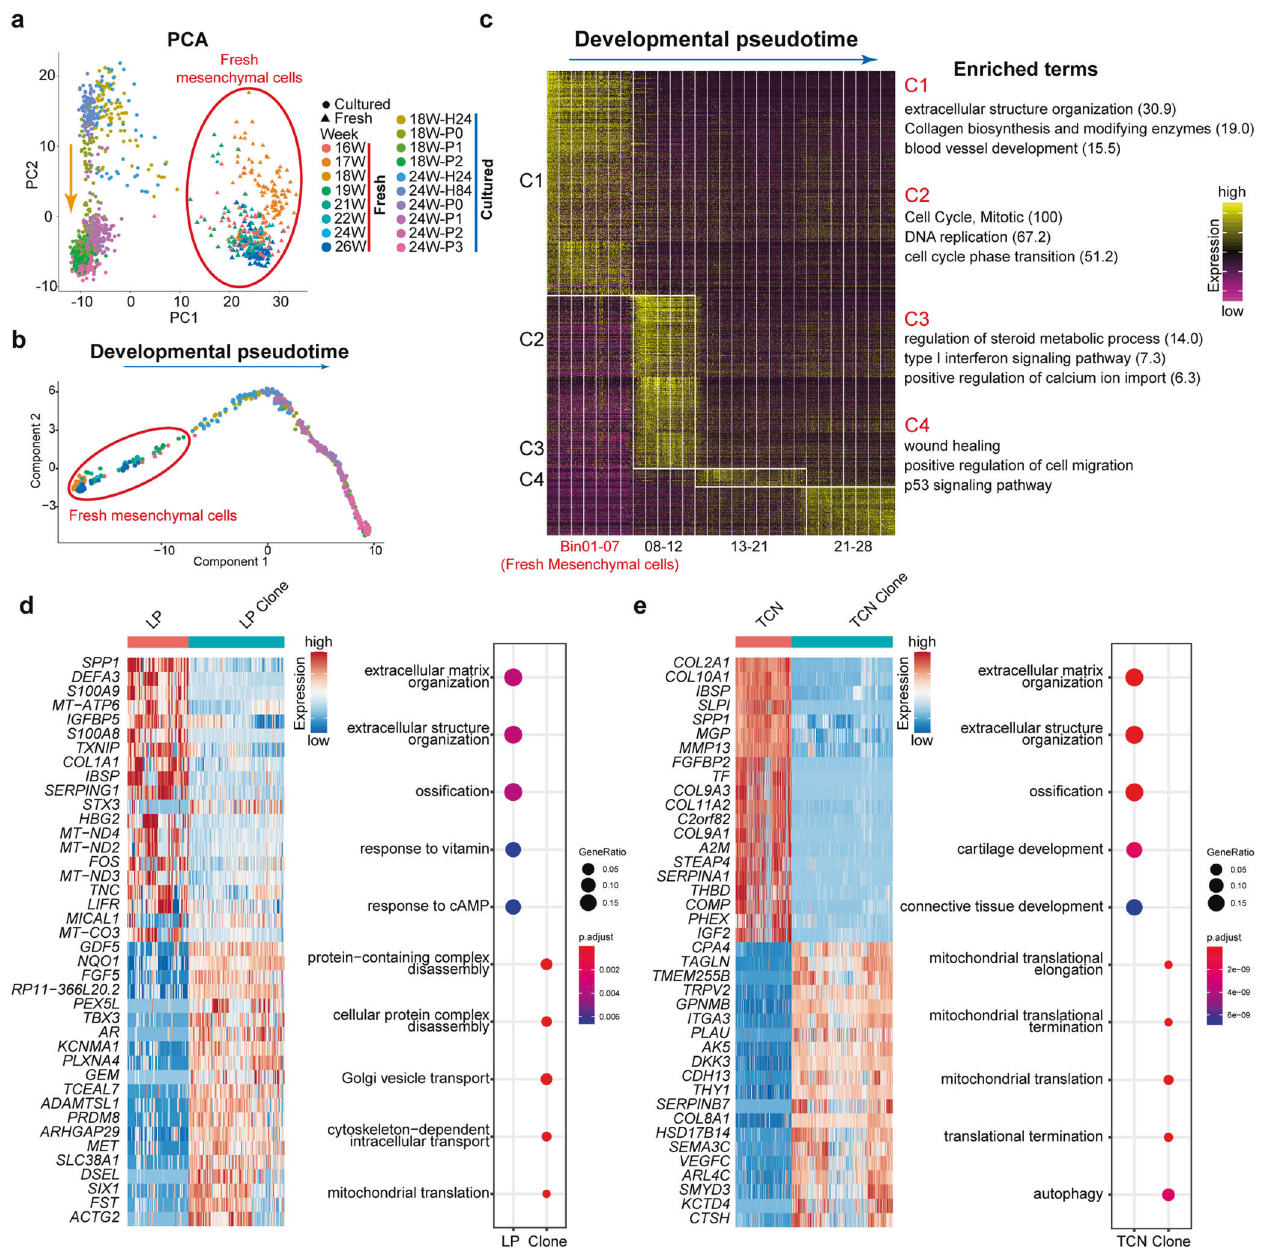
Fig. 6 Comparison between primary and cultured BM mesenchymal cells. a PCA plot showing relationship between primary and cultured BM mesenchymal cells. b Developmental pseudotime of primary and cultured BM mesenchymal cells. c Cells were split into 28 bins along the developmental pseudotime. Each bin contained 50 cells and the DEGs of each bin were shown by the heatmap. All bins were classi fi ed into four major clusters according to their expression patterns. And the enriched terms using all the DEGs in each cluster were listed on the right. The number in the bracket indicates – log10 ( P -value). d DEGs (left) and GO terms (right) showed that the fresh LP cells and LP clones exhibited high heterogeneity. e DEGs (left) and GO terms (right) showed that the fresh TCN cells and TCN clones exhibited great high great difference before and after culture. Both of which further expansion that could preserve the original disposition and suggested that the characteristics of MSC in vitro are not fully progenitor function of MSCs would be a great help for MSC- indicative of in vivo function. based bone regeneration. We also examined the CFU-F activity of Despite the bene fi cial effects of MSC therapy both in pre- human fetal BMNCs (Fig. 5). Stromal cells with CFU-F activity and clinical and clinical trials, more and more studies have produced multi-lineage differentiation ability in vitro were generally mixed results regarding their therapeutic ef fi ciency. The great identi fi ed as MSCs. However, many bone marrow stromal cells changes between freshly isolated MSCs and cultured cells may have the ability of multi-lineage differentiation potential and CFU- suggest a possible explanation for the discrepancy between F activity in vitro, but failed to form new bone when transplanted expected and actual results of MSC therapy. In the present in vivo. On the other hand, the expression pattern of many surface study, gene-expression pro fi les indicated an apparent gap markers, which are generally used for sorting MSCs displayed a